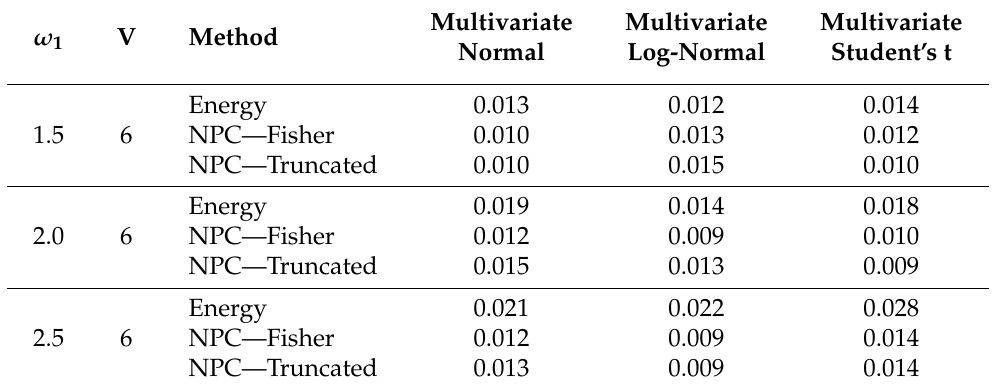
Table 4. Rejection rates with significance level α = 1% with differences in the correlation structure.